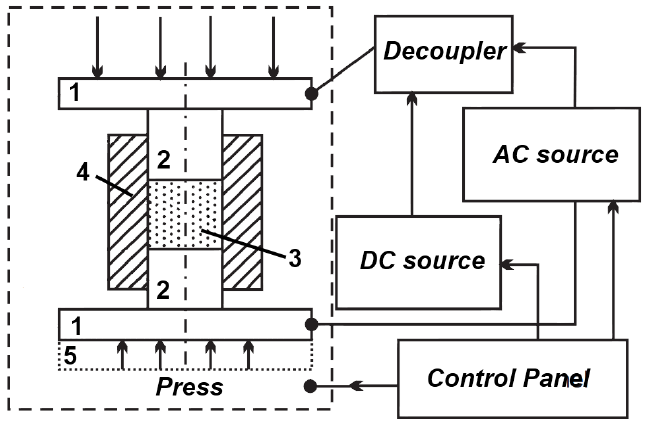
Figure 16. ERAN 2/1 installation for electric discharge sintering: 1—current-carrying plates of the hydraulic press; 2—punches (electrodes), graphite MPG-6; 3—powder mixture; 4—die, MPG-6 graphite; and